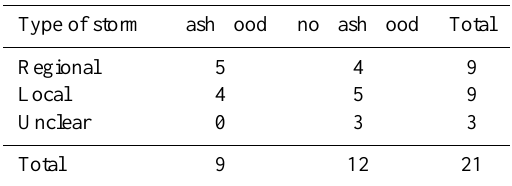
Table 3. Overview of type of storms of Wadi Watir in the period